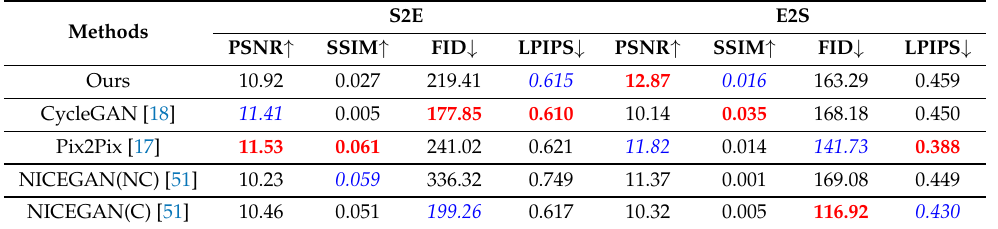
Table 4. Comparisons of IQA scores on SEN1-2 for S2E (SAR to EO) and E2S (EO to SAR) tasks. The best and second best results are highlighted as red bold and blue italic , respectively.